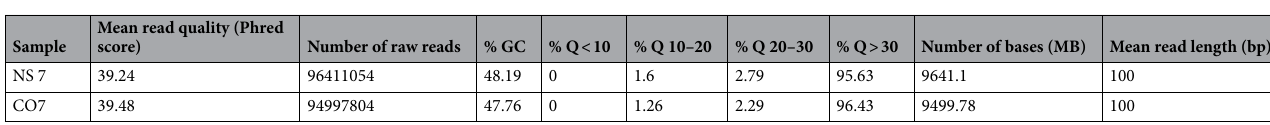
Table 1. Sequencing statistics of mulberry